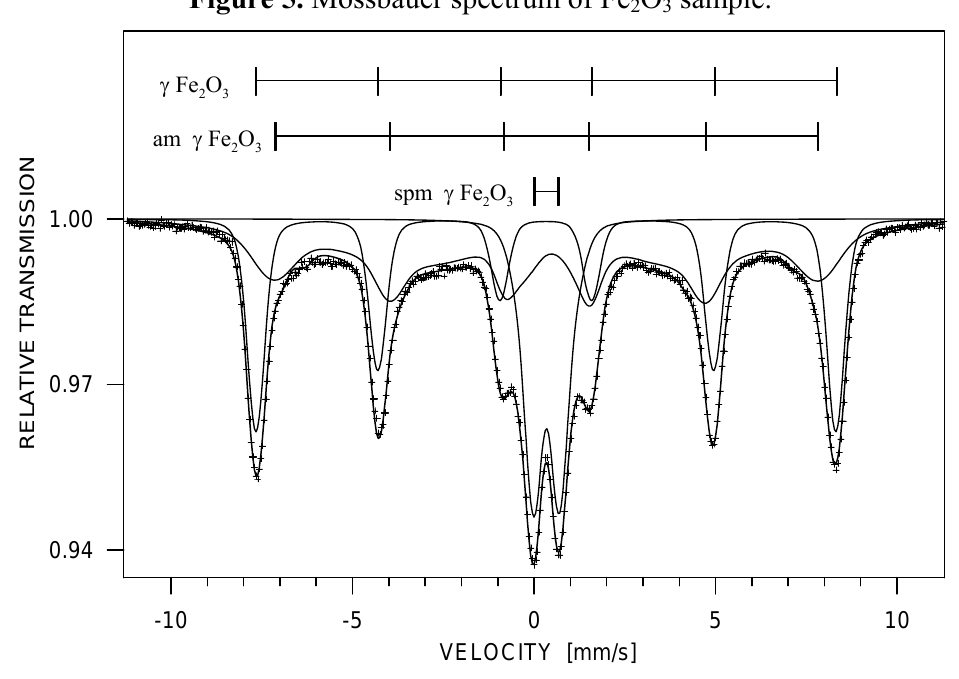
Figure 5. Mössbauer spectrum of Fe